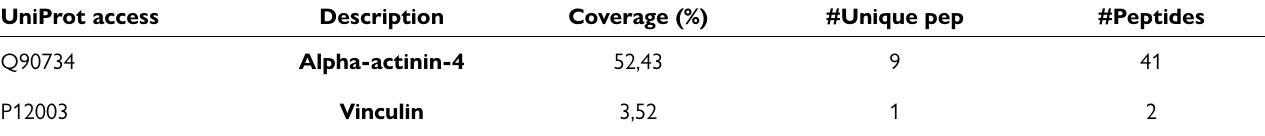
Table 1. List of the proteins identified by MS, probably involved in ECVF pathogenicity. UniProt